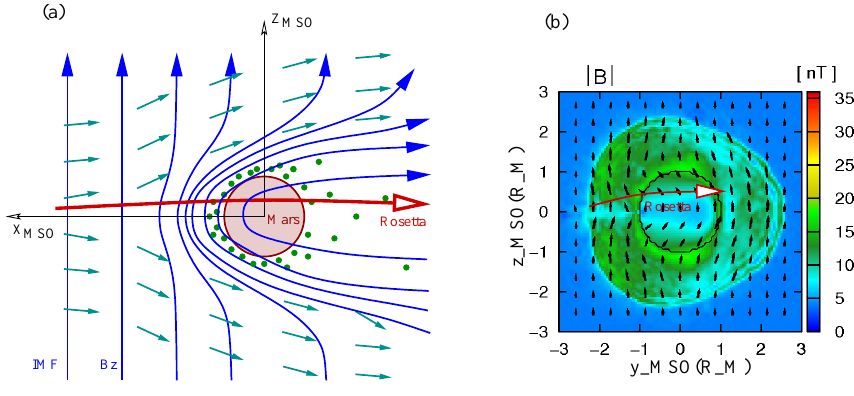
Fig. 10. Morphology of the IMF at the Rosetta swingby. (a) RPC-MAG data (see Fig. 3) as well as several hybrid simulation test runs with different IMF vector directions have shown that the IMF vector is mainly determined by its z-component to explain the measured negative B x component in Martian magnetosheath. (b) Simulation results of magnetic field in terminator plane in MSO coordinates. This figure explains the only slightly increase of magnetic field when Rosetta entered the MPR. In this swingby geometry Rosetta cannot cross the pronounced magnetic field increase at MPB as it would happened if Rosetta’s trajectory were in the polar